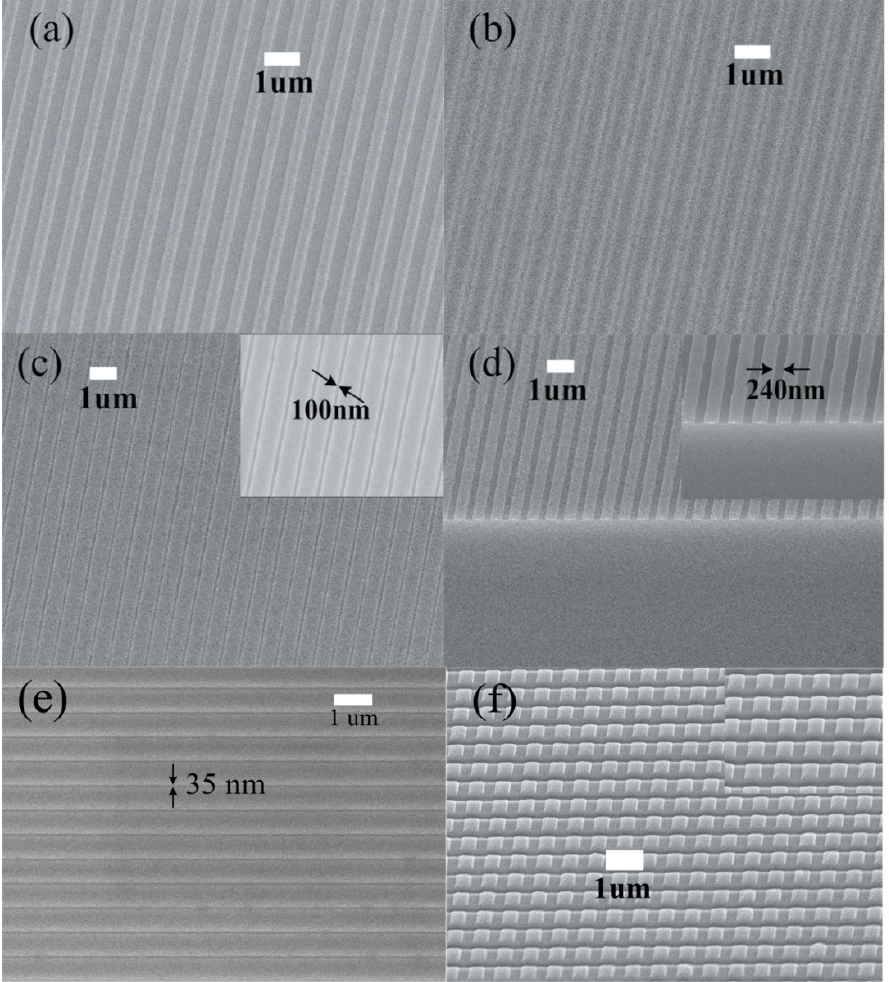
Figure 3. ( a ) Polycarbonate gratings with 150 nm height fabricated by nanoimprint and RIE, ( b ) polycarbonate patterns formed by annealing the gratings in ( a ) at 200 °C for 30 min, ( c ) SiO 2 gratings with 100 nm trenches fabricated by CHF 3 RIE with polycarbonate as etching masks from ( b ), ( d ) SiO 2 gratings with 240 nm trenches fabricated by CHF 3 RIE with polycarbonate as etching masks, annealed from 70 nm thick polycarbonate gratings, ( e ) polycarbonate gratings with 35 nm trench size after thermal annealing, and ( f ) dual imprints of 90 nm thick polycarbonate film.